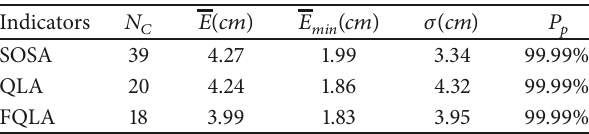
Table 1: Performance indices of three algorithms with 10 initial speeds.